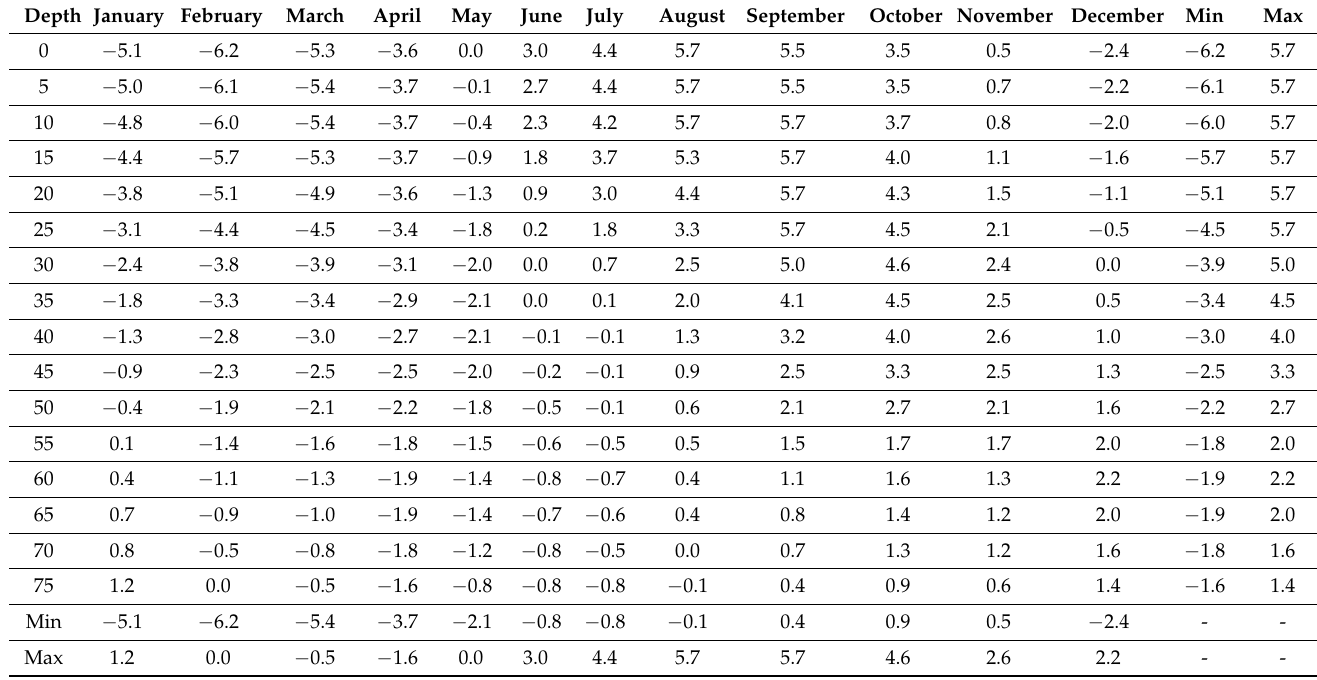
Table 1. Monthly temperature anomalies for the